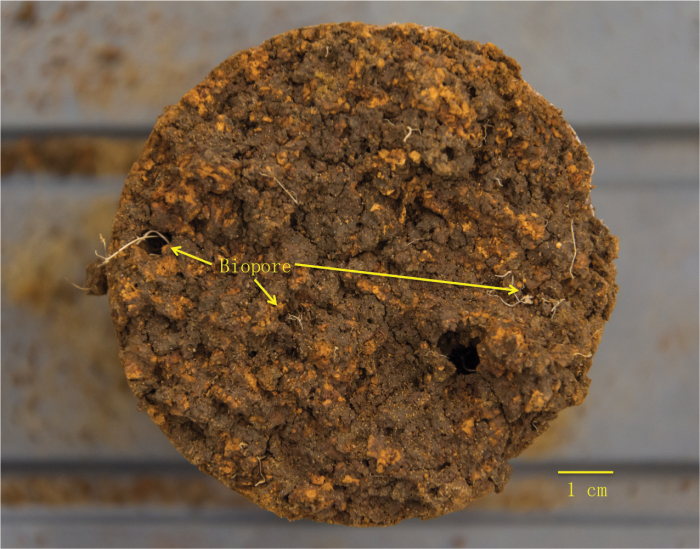
A horizontal soil surface at 65 cm depth of a soil core (sample #273) cleaned for root counting.